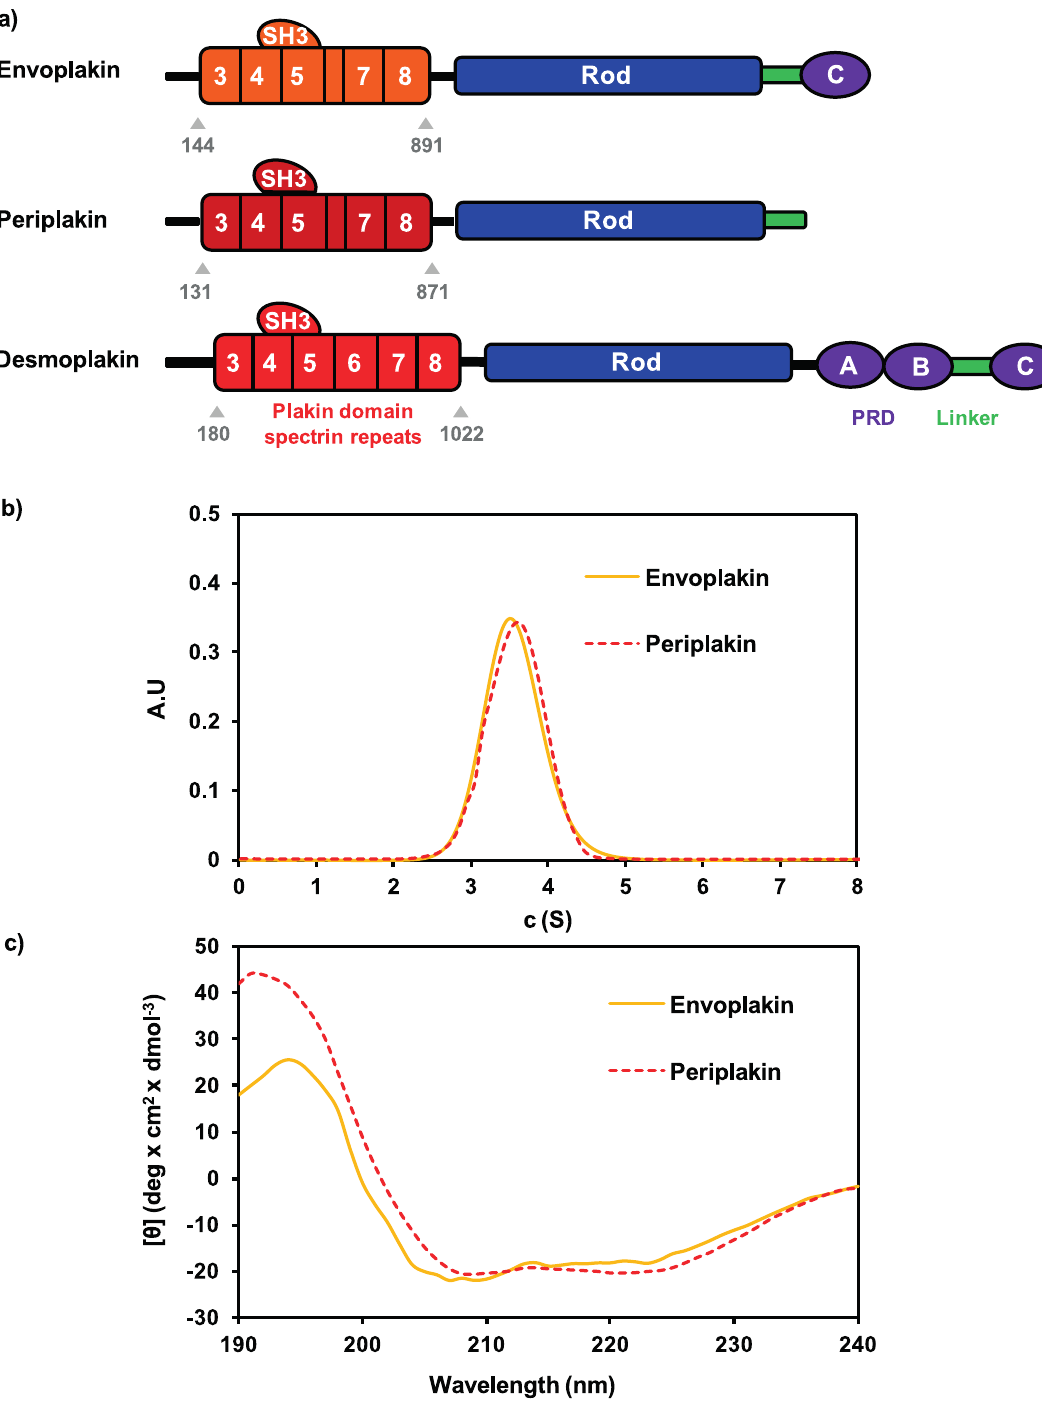
Figure 1. Structural and monomeric states of the plakin domains of envoplakin, periplakin and desmoplakin. (a) All three proteins all contain N-terminal head domains, central rod domains and C-terminal tail domains. The N-terminal head domains are composed of an extreme N- terminal region which is predicted to be unstructured and the plakin domain, which consists of five spectrin repeats (SRs) in periplakin and envoplakin and six SRs in desmoplakin. All three proteins have a Src homology 3 (SH3) domain embedded within a SR5 loop. The numbering and organisation of the SRs are as suggested previously [21]. The C-terminal tail of envoplakin contains a linker region (L) and one plakin repeat domain (PRD) designated C. The periplakin tail consists of a linker alone whereas the desmoplakin tail consists of three homologous PRDs, which are denoted A, B and C respectively, and a linker between PRD-B and PRD-C. The plakin domains (comprised of the residues indicated) of all three proteins were purified and used in all subsequent experiments. (b) Sedimentation velocity profiles of plakin domains of envoplakin (residues 144–891) and periplakin (residues 131–871) reveal monomeric states with molecular masses of 84 kDa in both cases. (c) CD spectra of these plakin domain constructs of envoplakin and periplakin show double-negative minima at 208 and 222 nm, indicating largely a -helical folds.